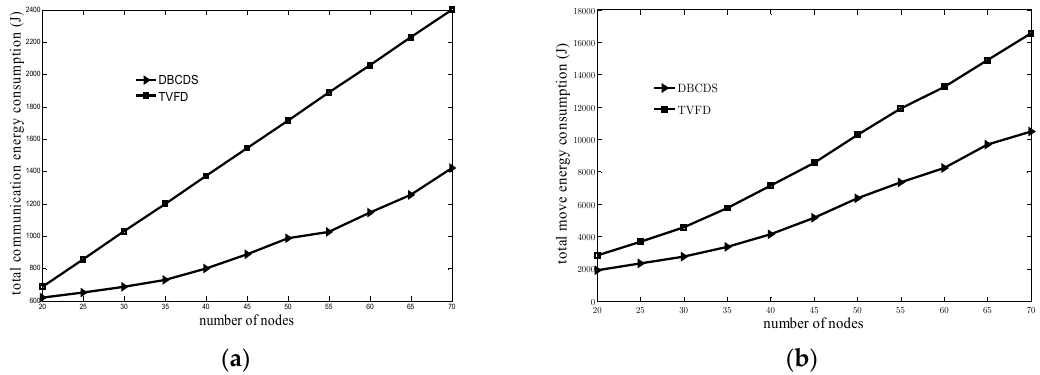
Figure 7. Comparison of total energy consumption: ( a ) Comparison of total communication energy consumption with various numbers of nodes; ( b ) Comparison of total movement energy consumption with various numbers of nodes.